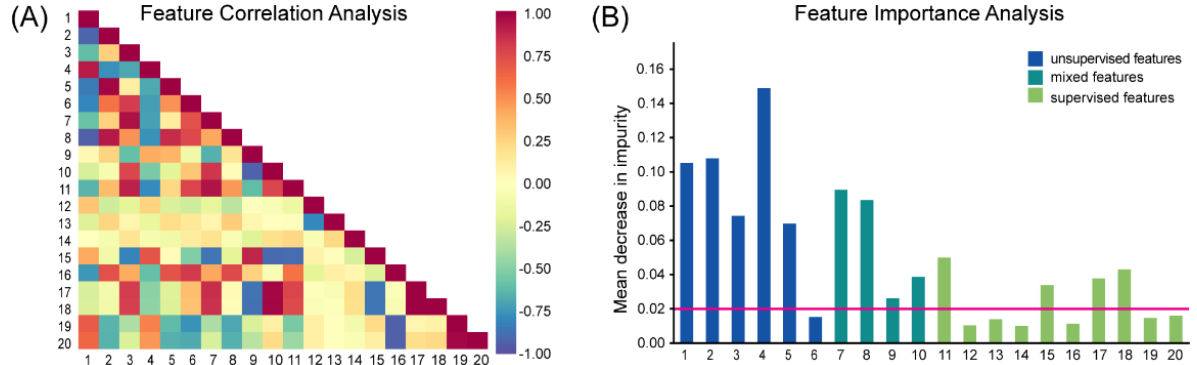
Figure 6. Feature correlation and importance analysis. ( A ) The feature correlation heatmap showed some high and low correlations between certain feature pairs. ( B ) Feature importance analysis based on the tree-based meta-transformer. By choosing 0.02 as the threshold, five in six unsupervised features, all four mixed features, and four in ten supervised features were selected.